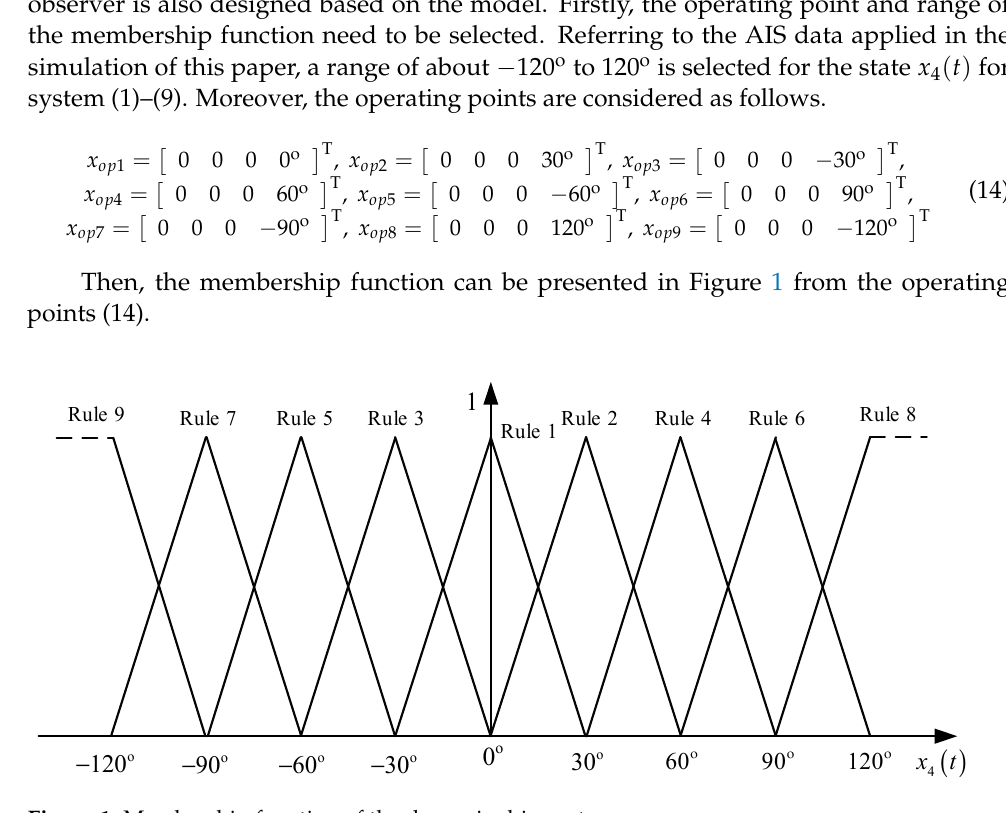
Figure 1. Membership function of the dynamic ship system.